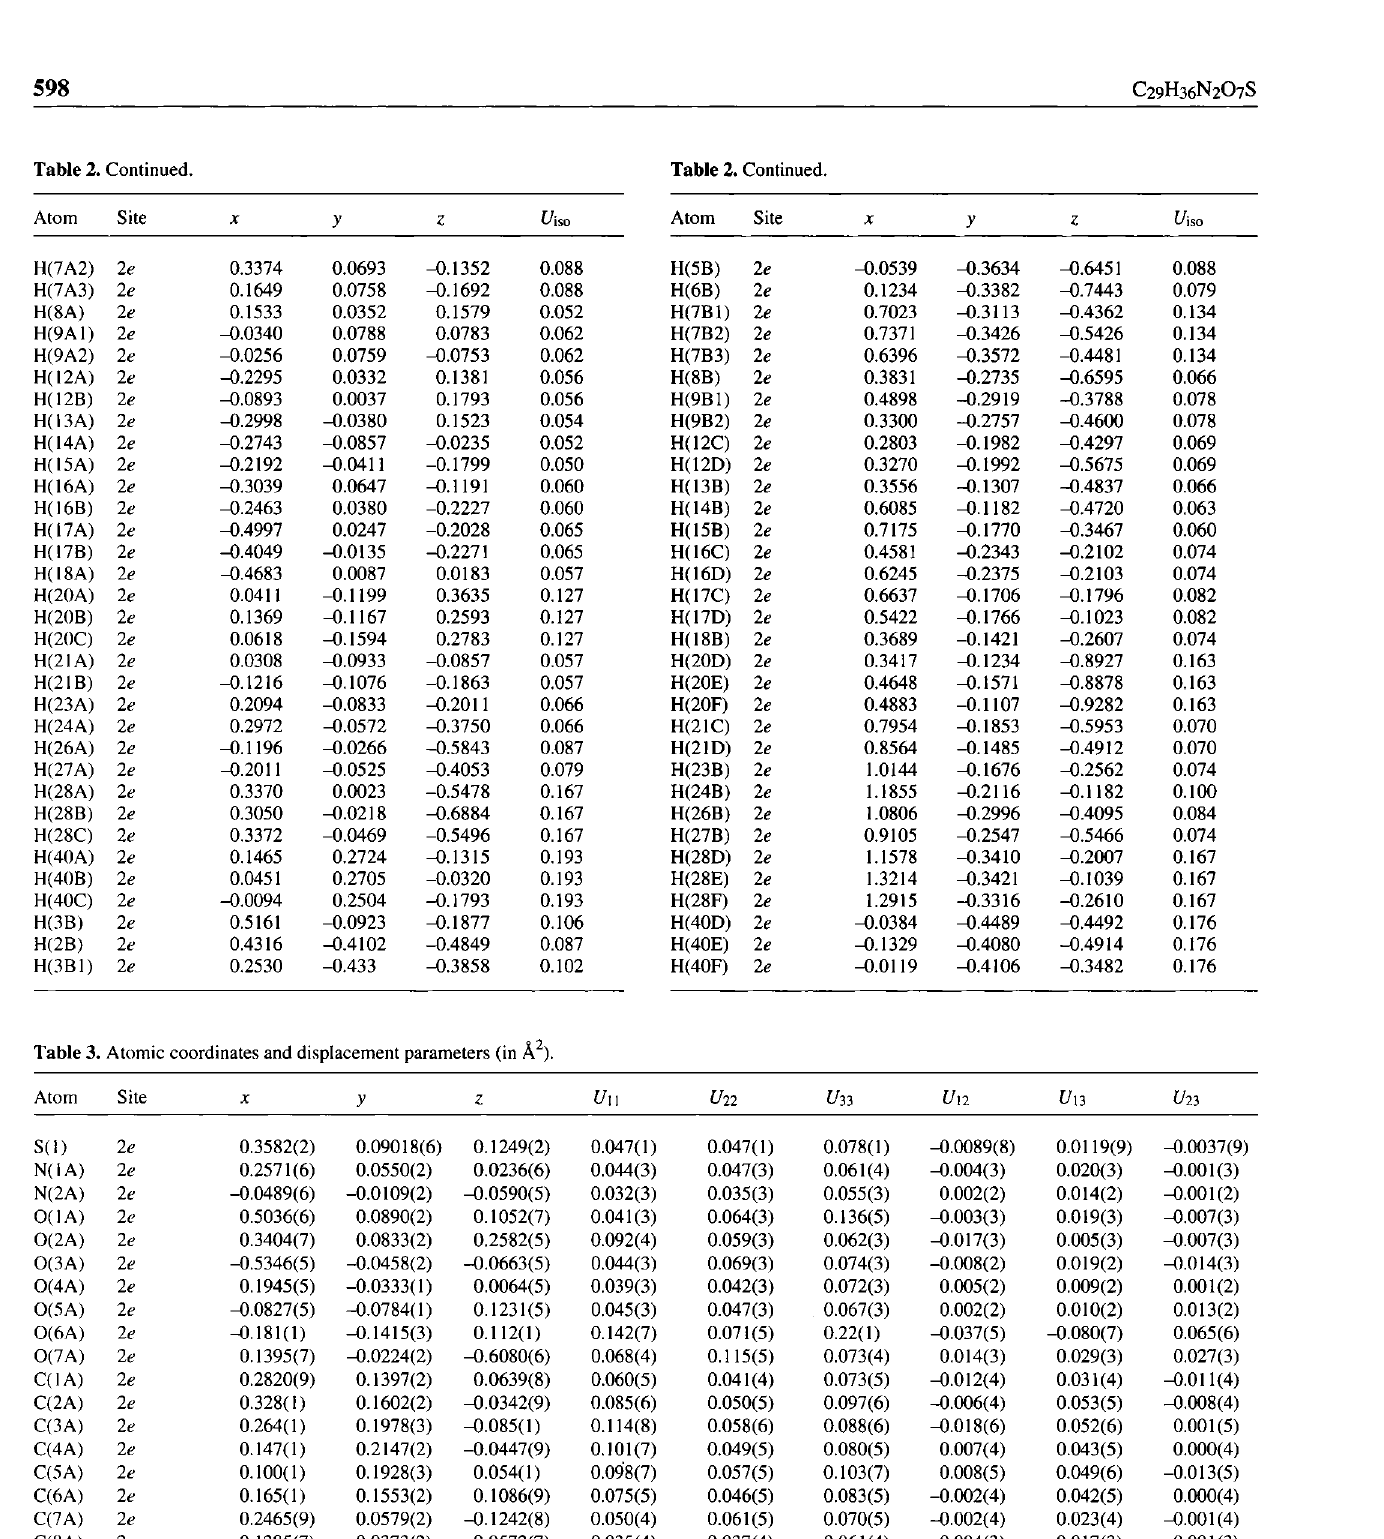
Table 3. Atomic coordinates and displacement parameters (in Ä 2